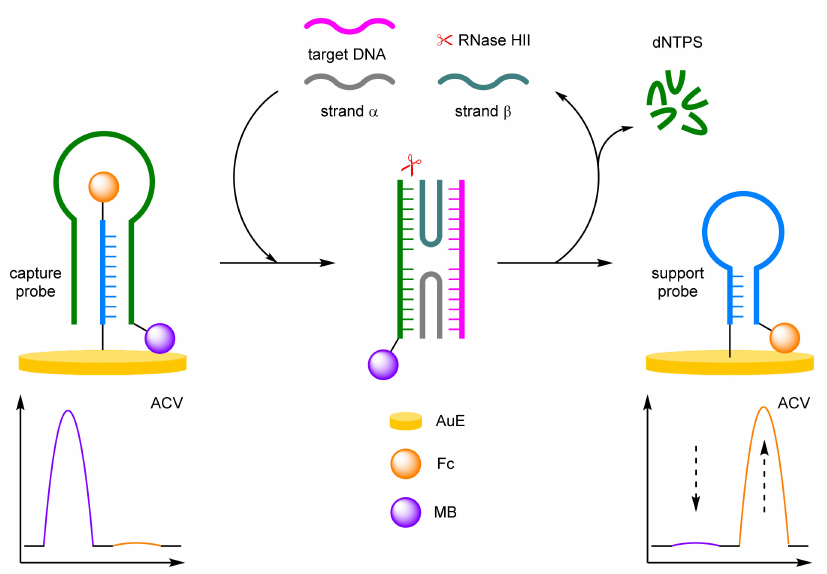
Figure 13. Schematic representation of a biosensor for the detection of single point mutation via DNA four-way